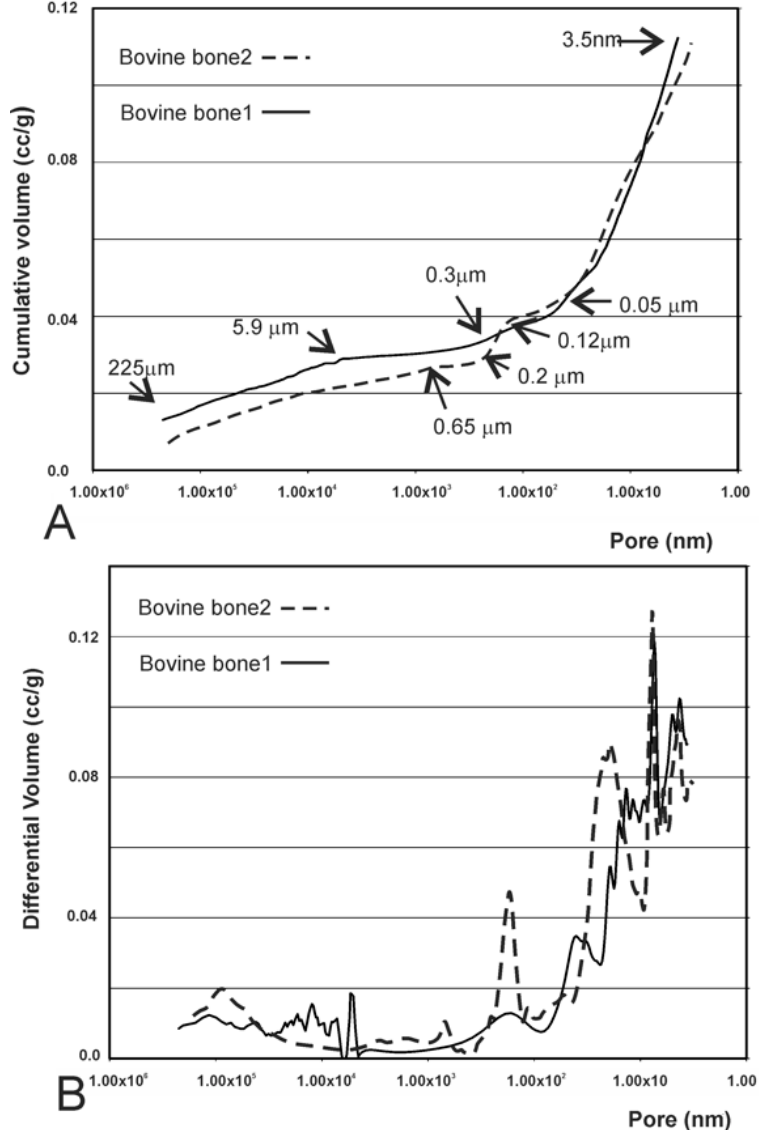
Figure 6. ( A ) Mercury intrusion curves of bovine bone 1 and bovine bone 2 measured by mercury porosimetry: cumulative intruded volume vs. pore diameter and ( B ) differential-intruded volume vs. pore diameter.